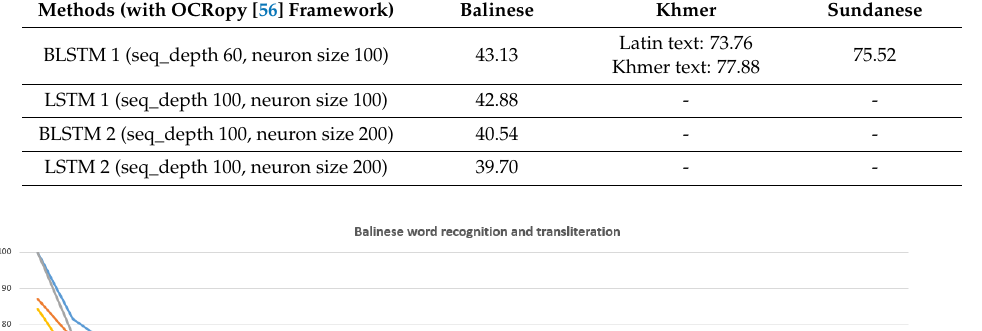
Table 8. Experimental results for word recognition and transliteration tasks (in % error rate for test). Methods (with OCRopy [56] Framework)